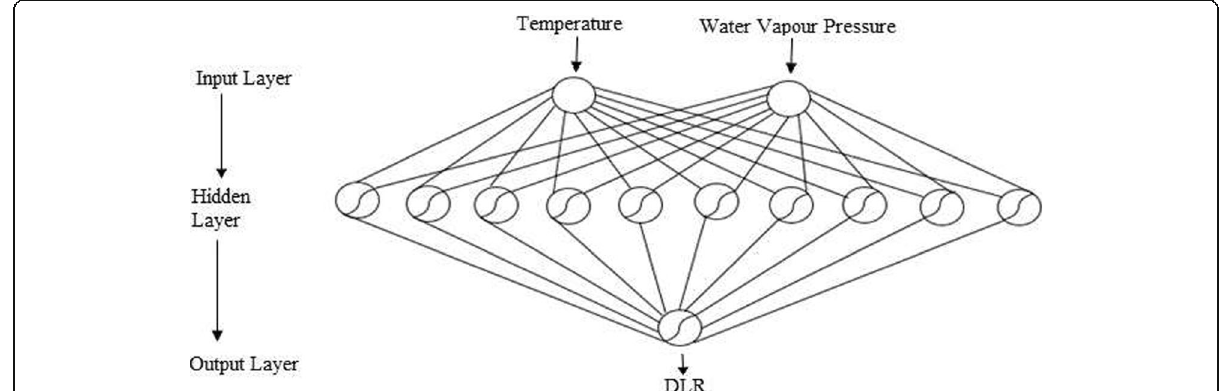
Fig. 1 The structure of the ANN system used in this study